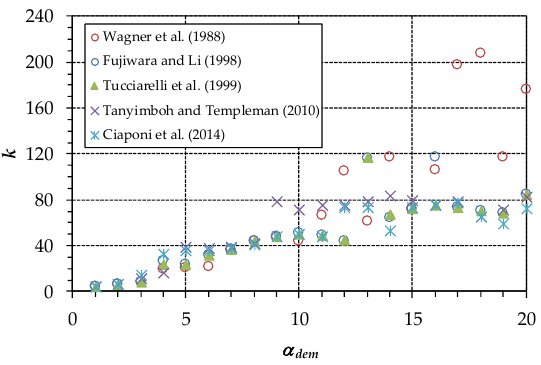
Figure 3. First case study. Number k of iterations as a function of α dem for the various formulations.